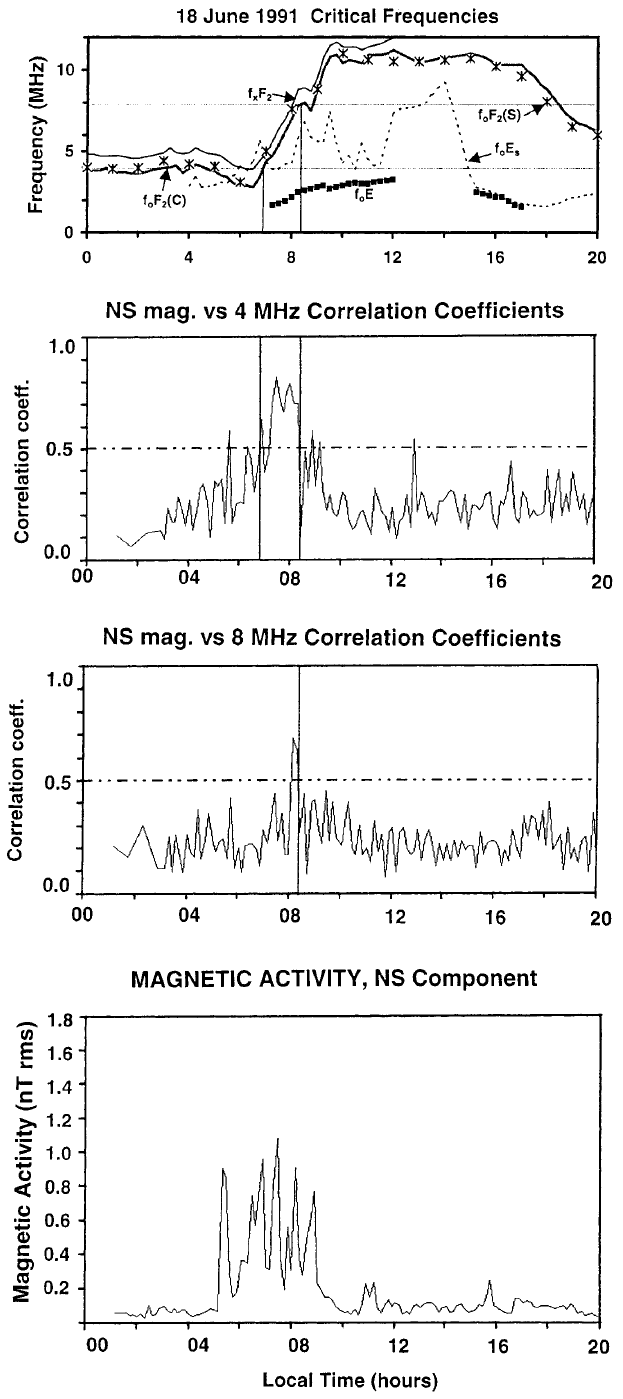
Fig. 4. Relationship between correlated ionospheric and magnetic oscillations and ionospheric parameters on 18 June 1991. Top panel shows E- and F-region critical frequencies at Canberra ( C ) and Sydney ( S ); middle two panels illustrate the variation in the ground- ionosphere correlation coe(cid:129)cients for the NS magnetic component and 4 and 8 MHz sounding frequencies; and bottom panel depicts the variation in pulsation activity in the NS component during this day. Horizontal lines indicate the two radio sounding frequencies and vertical lines show when f F2 reached these frequencies. K on this day 0 p ranged from 3+